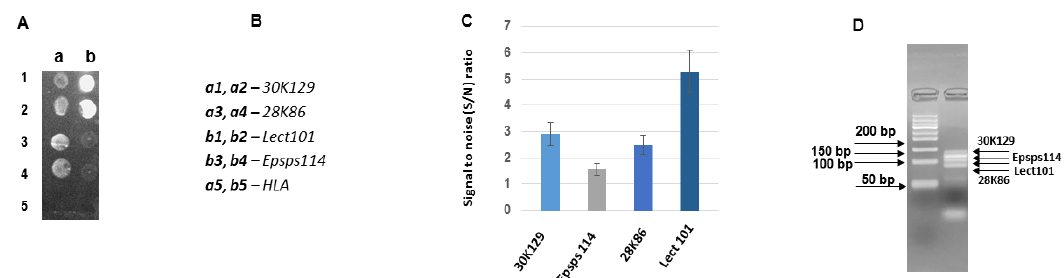
Figure 7. Hybridization of asymmetric multiplex PCR (N3) products with the probes Lect101, epsps114, 28K86 and 30K129 on a biochip. ( A ) Hybridization image ( a , b ) designations of the columns for the probe arrangement; ( B ) The arrangement of the probes on the biochips; ( C ) Analysis of hybridization; the hybridization signal intensities estimated as signal to noise (S/N) ratio. ( D ) Agarose gel electrophoresis of asymmetric PCR products. Total DNA per hybridization is 477 ng, the amount of fluorescent dye Cy3 is 6 pmol.